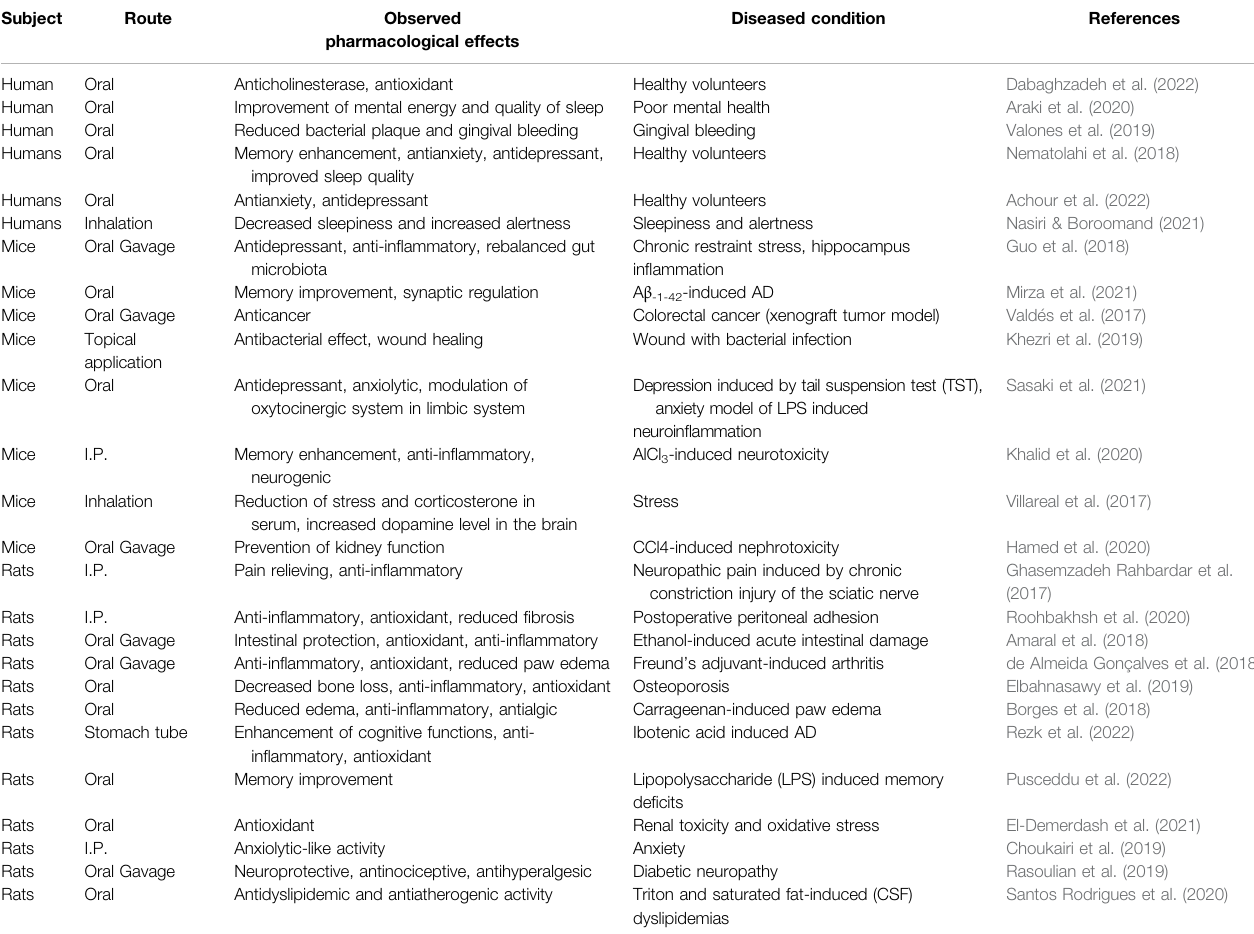
TABLE 1 | Pharmacological properties of R. of fi cinalis